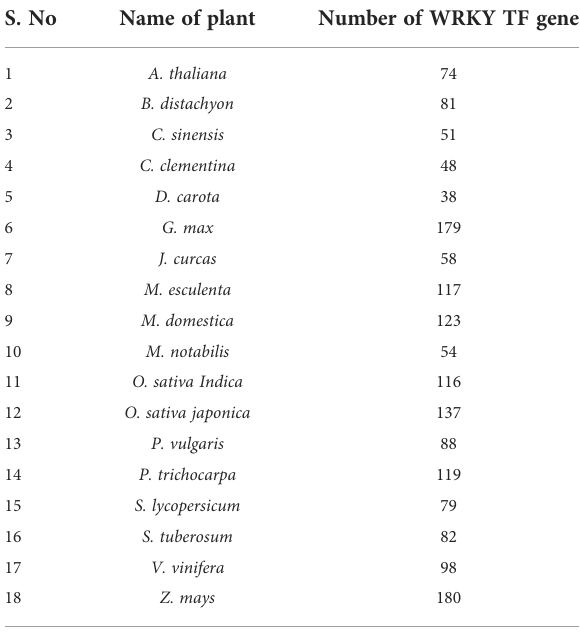
TABLE 1 Number of WRKY TFs genes in